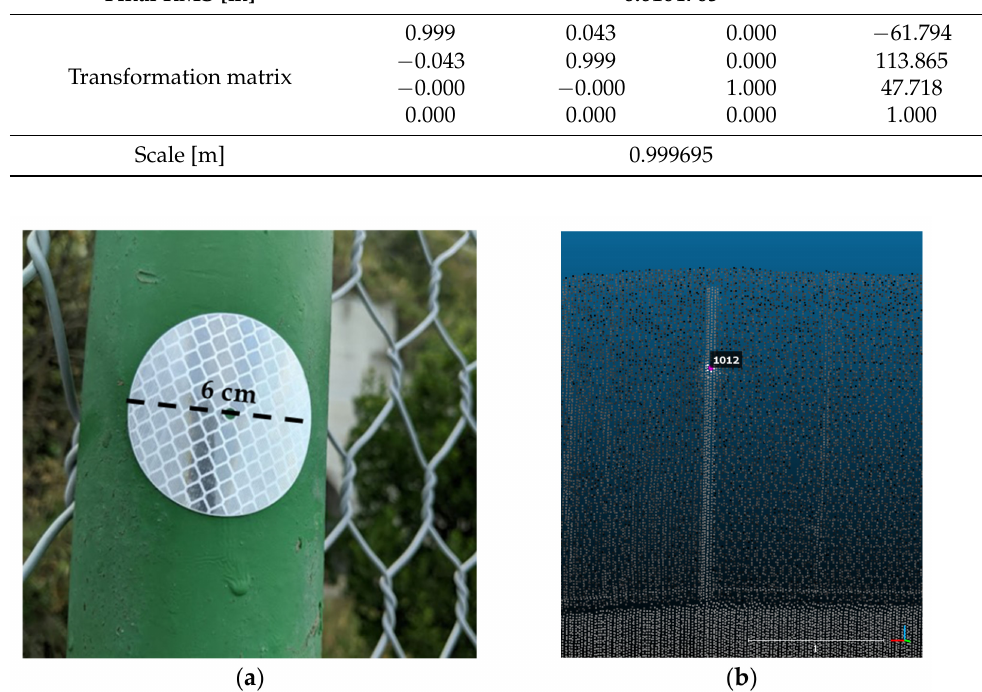
Figure 3. Reflector for the georeferencing of TLS point cloud: ( a ) Detail; ( b ) Identification in the point cloud (different value of intensity